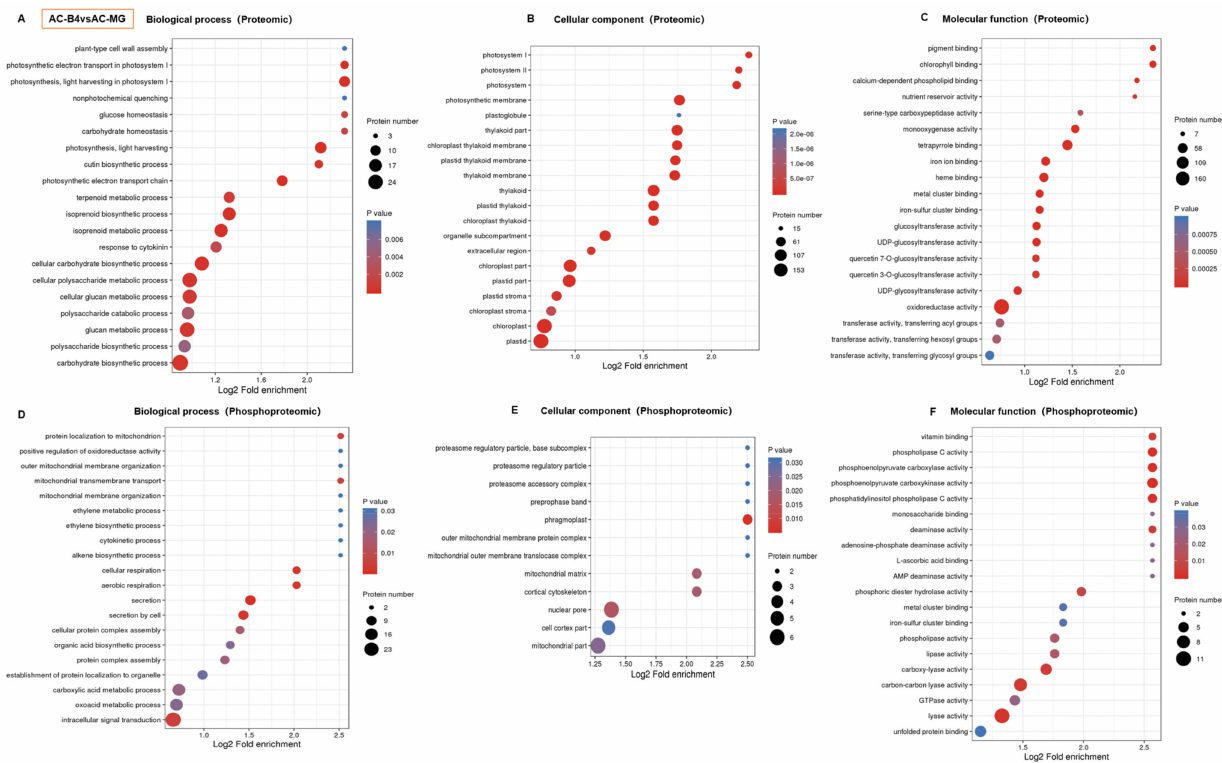
Figure 5. Bubble charts of enrichment distributions of DEPs and DEPPs in GO functional classification (AC-B4 vs. AC-MG). ( A – C ) bubble charts of enrichment distributions of DEPs (proteome) in GO functional classification; ( D – F ) bubble charts of enrichment distributions of DEPPs (phosphoproteome) in GO functional